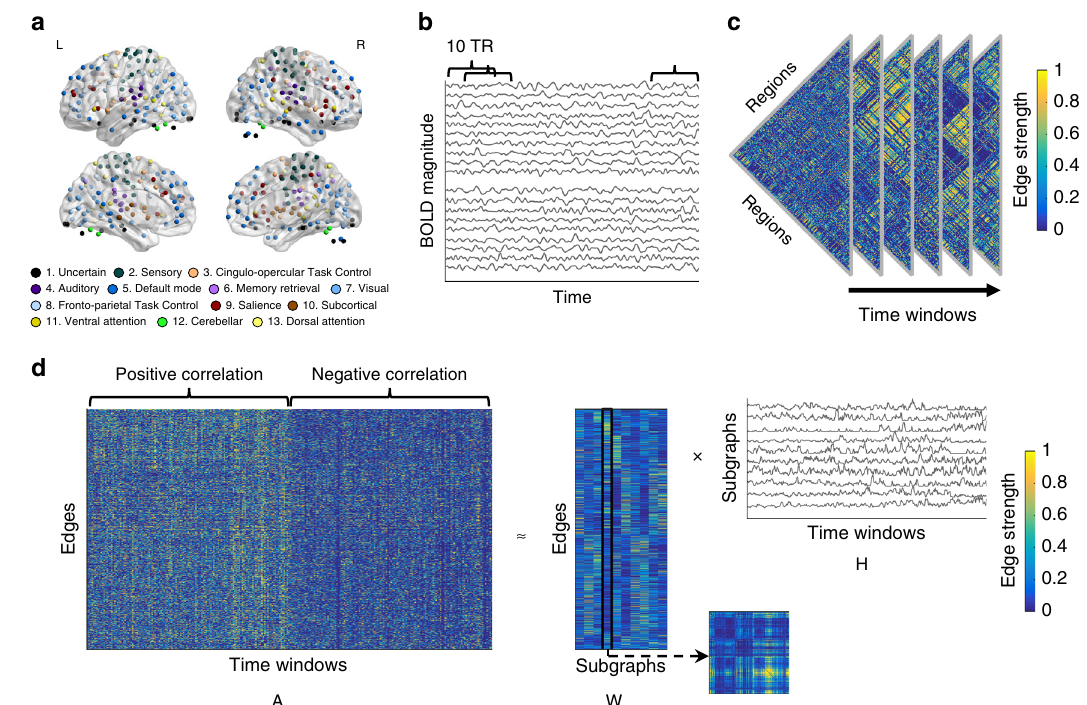
Fig. 2 Schematic overview of the method. a Regions of interest (ROIs). Functional MRI BOLD signals were extracted from spherical ROIs based on the previously de fi ned parcellation 27 . We only kept 247 ROIs that had usable data from all subjects. Each ROI can be assigned to one of 13 putative functional systems. The brain fi gure was visualized by the BrainNet Viewer 42 under the Creative Commons Attribution (CC BY) license (https://creativecommons. org/licenses/by/4.0/). b An example of Pearson correlation coef fi cients calculated between regional BOLD time series over the course of the experiment. Each BOLD time series was divided into 10-TR (25 s) time windows, and consecutive time windows were placed every 2 TRs leading to 80% overlap between consecutive time windows. Pairwise Pearson correlation coef fi cients were calculated between ROI time series in each time window. c An example of edge strength over time. In each time window, there were 247*(247 − 1)/2 edges. d Nonnegative matrix factorization (NMF). In each time window, the matrix of edge strengths was unfolded into one column. Then, edges from all time windows in all participants were concatenated into a single matrix. Each row in the full data matrix contained an edge (pairwise correlation coef fi cients between BOLD time series from two ROIs) and each column contained a time window (across all scans and participants). Correlation values in this matrix were strictly non-negative; the full data matrix was divided into two halves, with one half containing the positive pairwise correlation coef fi cients (zero if the correlation coef fi cient was negative) and one half containing the absolute values of negative pairwise correlation coef fi cients (zero if the correlation coef fi cient was positive). Thus, subgraphs were identi fi ed based on both the similarity of positive functional connectivity and the similarity of negative functional connectivity together. Then, NMF was applied to decompose the concatenated matrix into a matrix W , which encoded the strengths of edges for each subgraph, and a matrix H , which encoded the time-dependent expression of each subgraph. For example, the strength of edges of the fourth subgraph (the fourth column in the matrix W ) can be folded into a squared matrix, re fl ecting the edge strength between every pair of which we performed NMF was divided into two-halves, with the fi rst half corresponding to positive functional connectivity and the second half corresponding to negative functional connectivity.